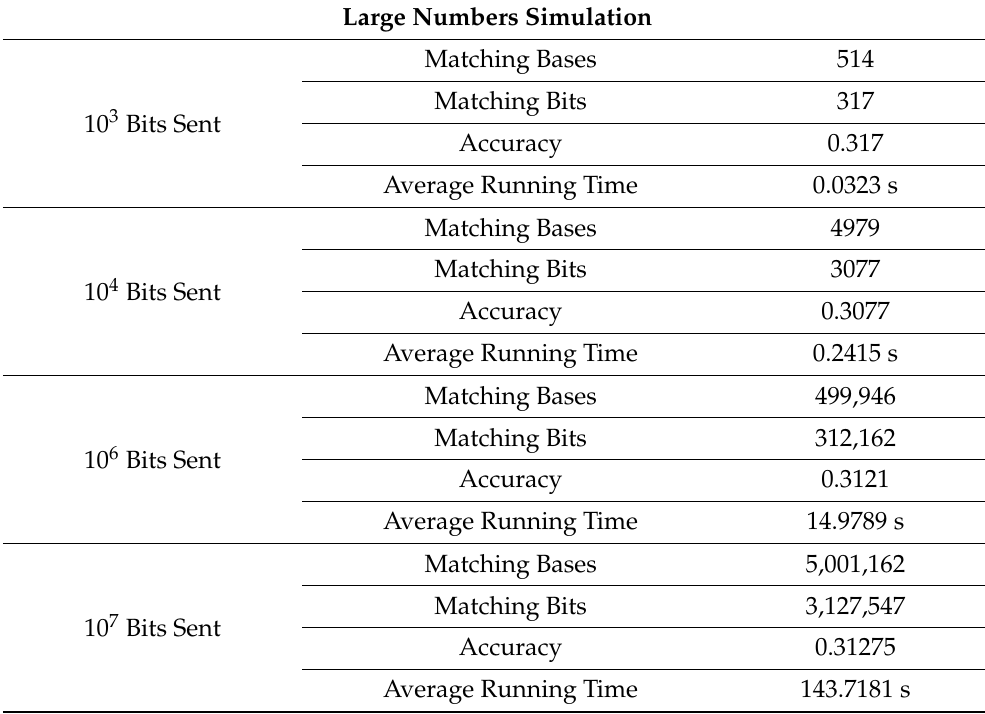
Table 9. Large number simulations for Alice, Bob and Eve setup, including average running